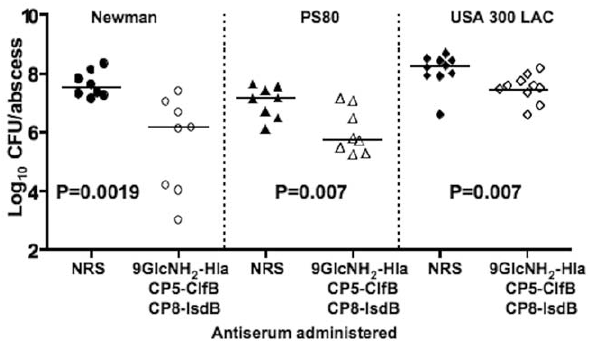
Figure 6. Protective efficacy of 9GlcNH 2 -Hla, CP5-ClfB or CP8- IsdB combining antibodies against S. aureus skin abscess formation. Mice were passively immunized with 300 m l of antisera mixed together and administered 24 h and 4 h prior to challenge with indicated S. aureus strains mixed with 60–87 m m dextran beads. The CFU/abscess recovered in mice vaccinated show a significant reduction compared to the NRS group (p values determined by Mann-Whitney test).